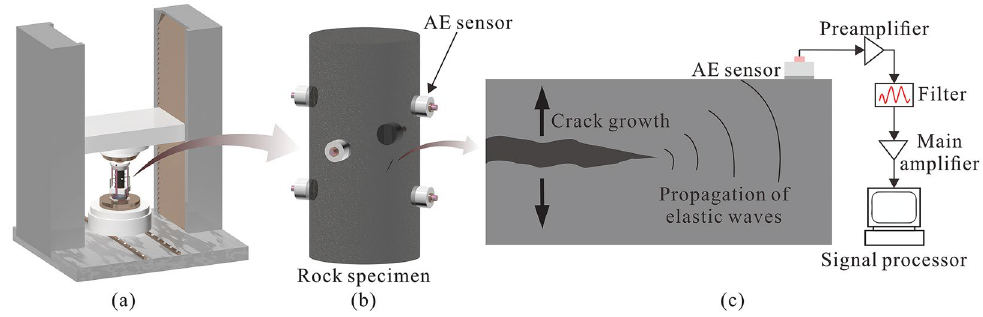
Figure 2. Schematic view of uniaxial compression tests with AE recording. ( a ) Loading system; ( b ) AE monitoring system; and ( c ) AE signal